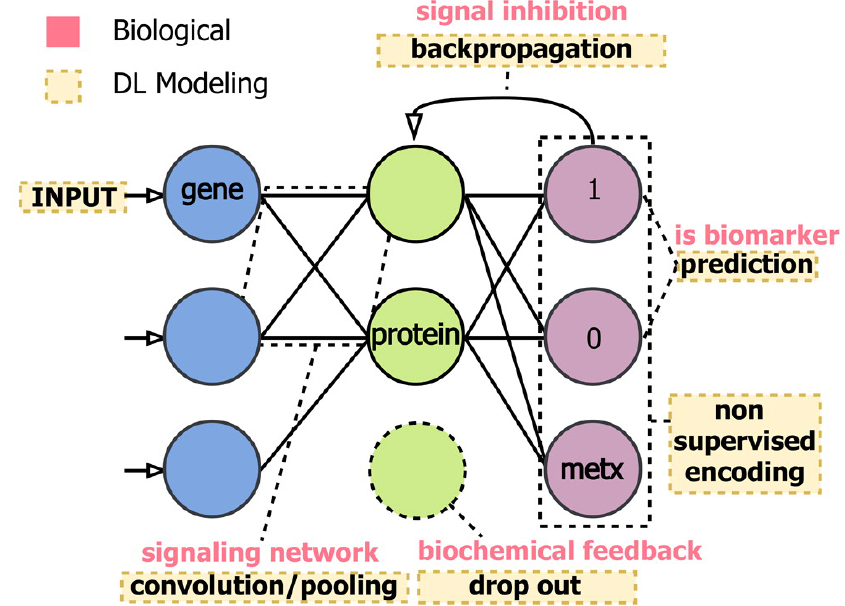
Figure 23. The multiomics method represented connects biological (i.e., signal inhibition, signaling network and biochemical feedback) with DL modeling (backpropagation, prediction, convolution, etc.), aiming to maximize the robustness of the approach for the identification of biochemical features referred to specific phenotypes. Figure reprinted from Ref. [124] under the terms of the Creative Commons Attribution Noncommercial